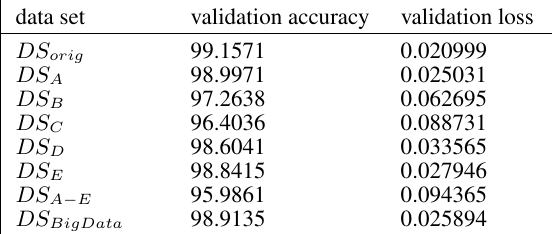
Table 4. Training information for the different data